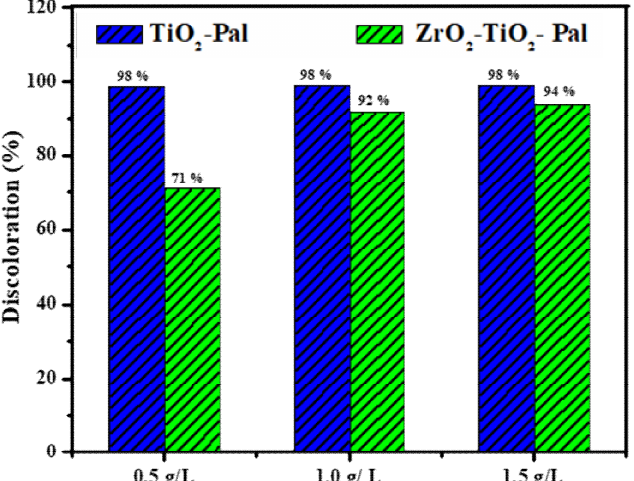
Figure 6. Discoloration percentages of Remazol Blue dye using 0.5 g L − 1 , 1.0 g L − 1 , and 1.5 g L − 1 of photoactive material under UV light.